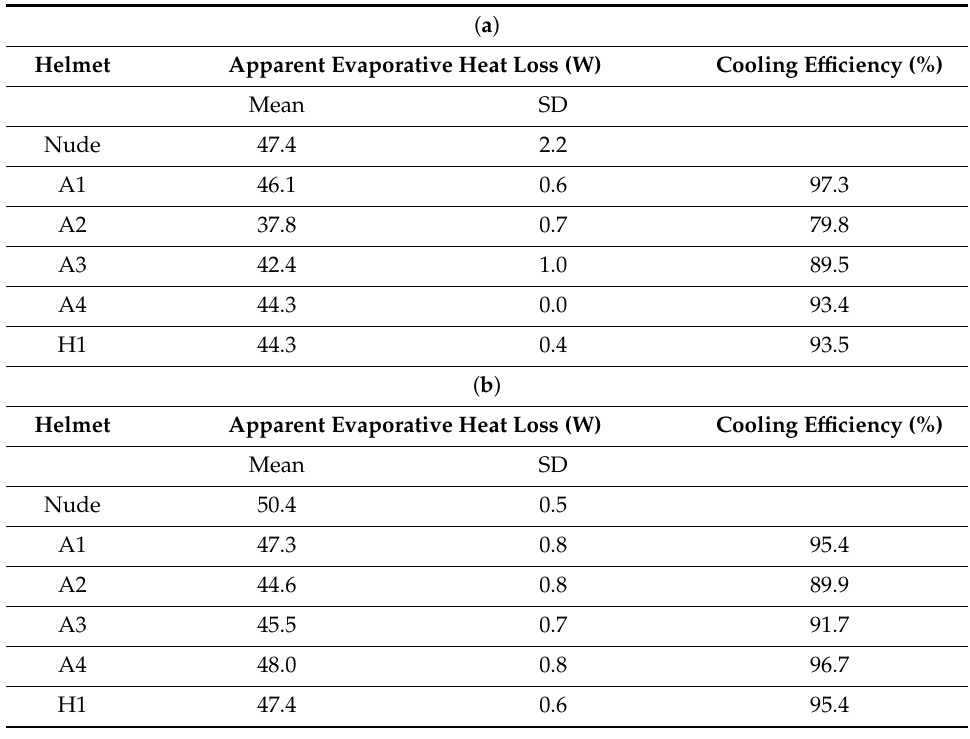
Figure 7. Apparent evaporative heat loss of helmet ensembles at tested velocities (confidence intervals obtained for a 95% confidence level and a sample size of three). Table 4. ( a ) Apparent evaporative-heat-loss values at 3 m / s. ( b ) Apparent evaporative-heat-loss values at 6 m /